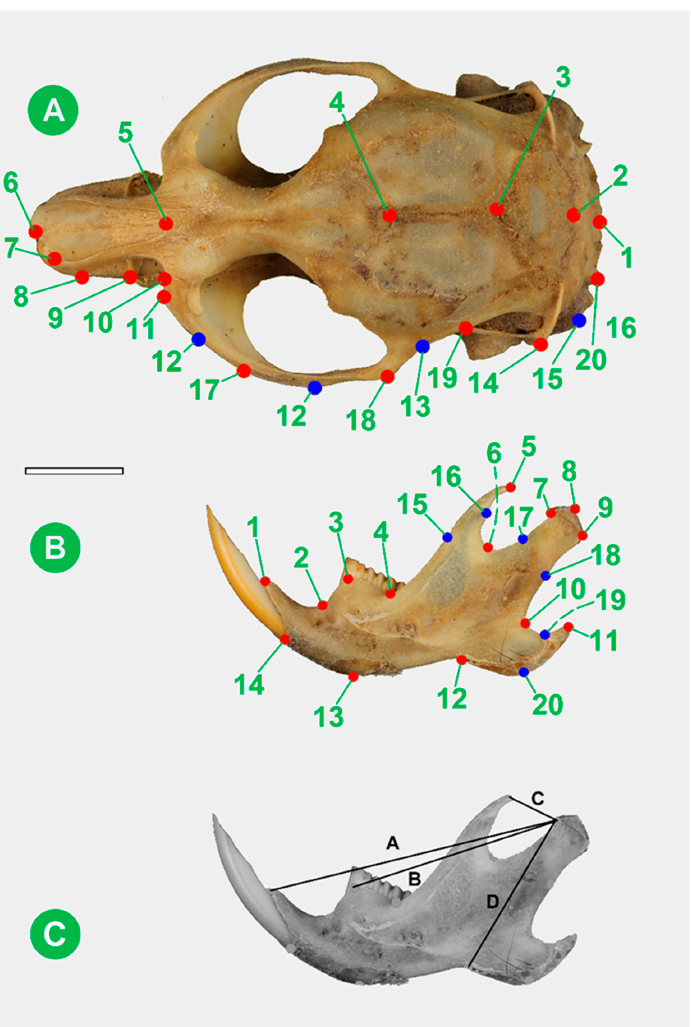
Figure 1. Locations ( A ): the dorsal projection of the cranium, ( B ): the lateral projection of the man- dible) of anatomical (type I) landmarks (red dots) and mathematical (type III) landmarks (blue dots) and ( C ): four linear distances (A: incisor; B: molar; C: temporal; D: masseter) that served as a basis for calculation of morpho-ecological indices (Appendix A). Green numbers indicate the landmark numbers. Scale bar: 5 mm.